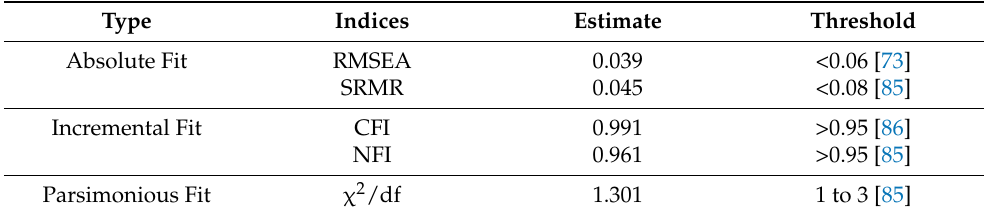
Table 6. Confirmatory factor analysis fit